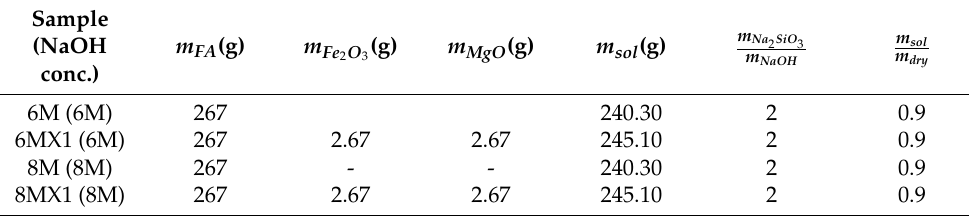
Table 2. Mass ratio of materials used in the production of the mixtures. Sample